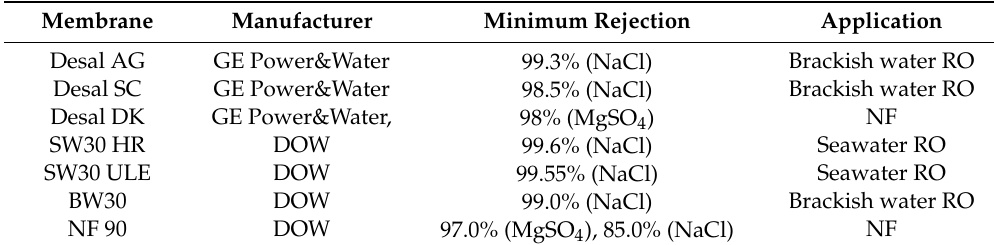
Table 3. NF and RO membrane used during test cell experiments.